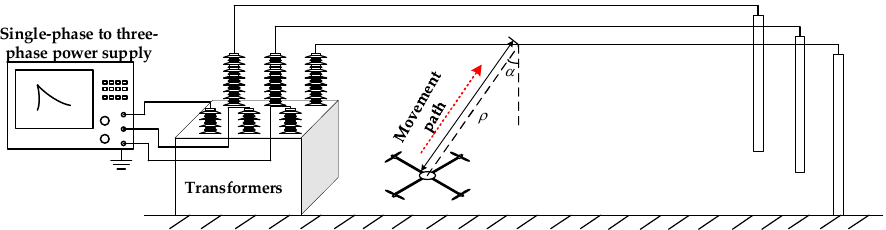
Figure 19. Schematic diagram of the experimental platform.